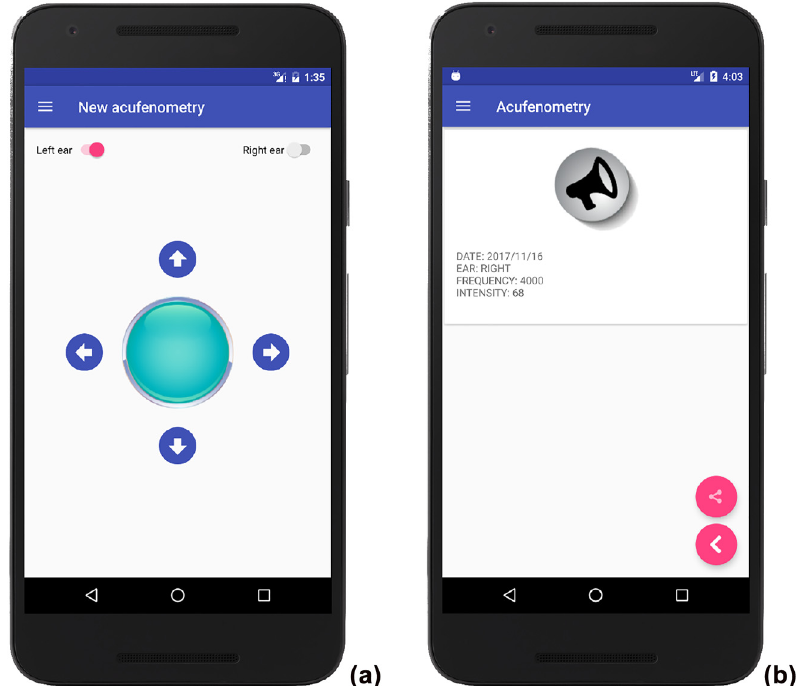
Figure 4: The acufenometry test implemented in the app: (a) the interface for pitch and loudness matching and (b) the returned